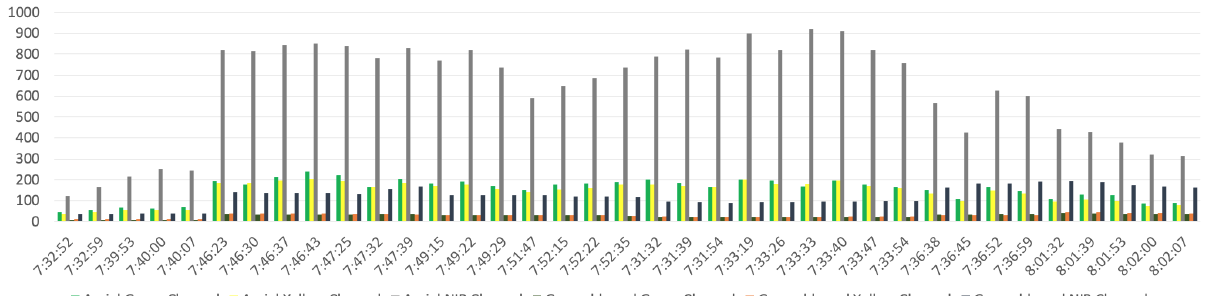
Figure 17. Comparison of aerial and ground-based spectrometer green, yellow, and NIR channel data from target plant during morning cycles before calibration.